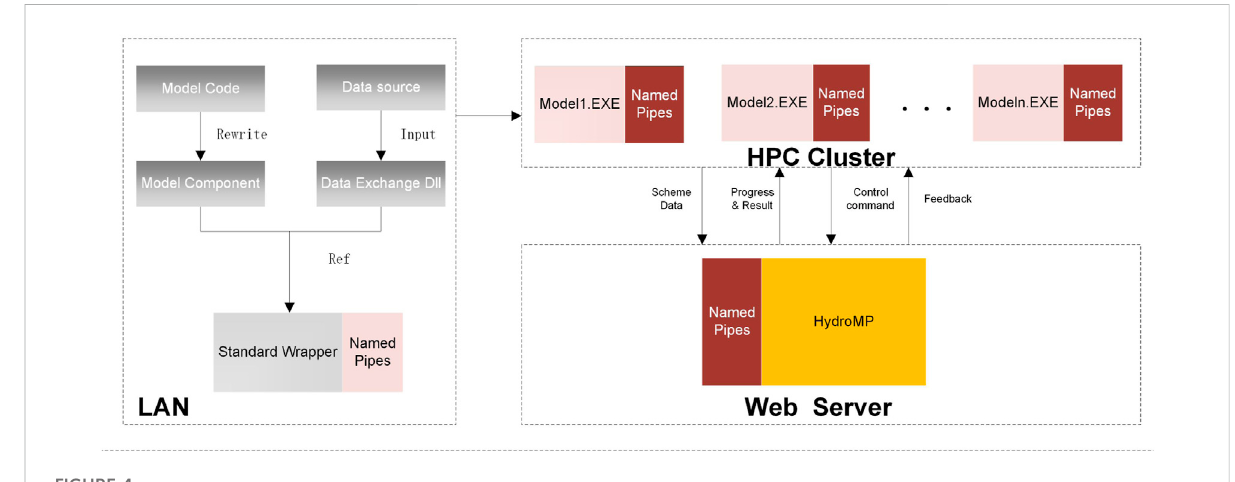
FIGURE 4 Interactive process between platform, model wrapper and DLL fi les.